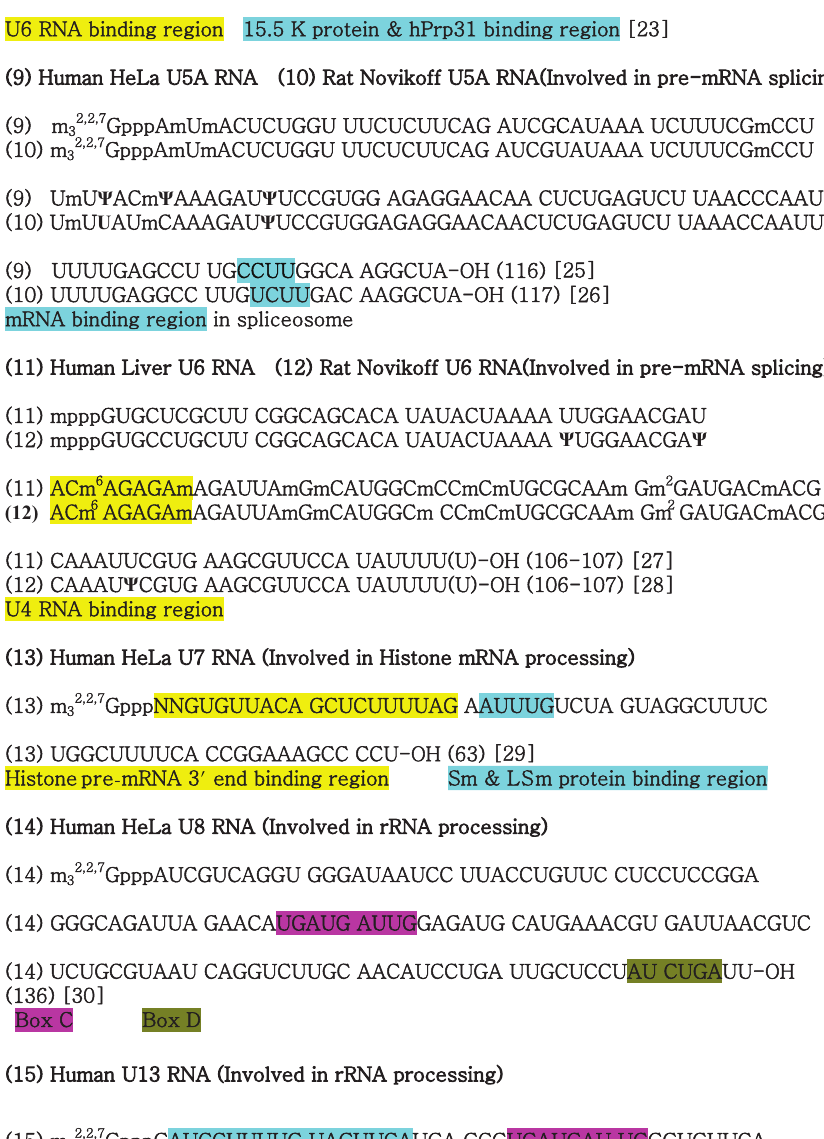
Figure 11: Sequences of major snRNAs (see [15–30]). The sequences of major snRNAs from human and rat involved in splicing and processing are aligned for comparison. The sequence elements in major spliceosomal snRNAs and processosomal snoRNAs are highlighted in the sequences. Those are the pivotal motifs for the function. The numbers in parenthesis are the chain length of the RNAs.